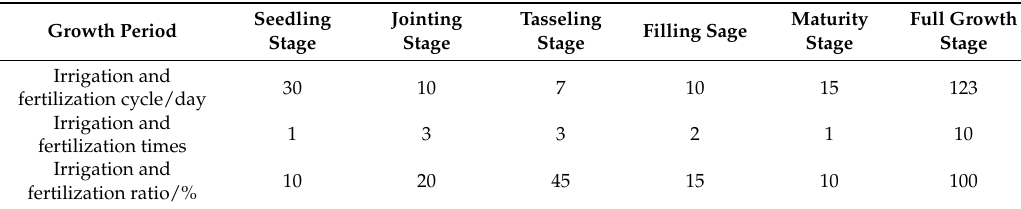
Figure 3. Layout of the design of mulched drip irrigation in this study. The unit of the numbers is m. Table 1. Maize irrigation and fertilization treatment.